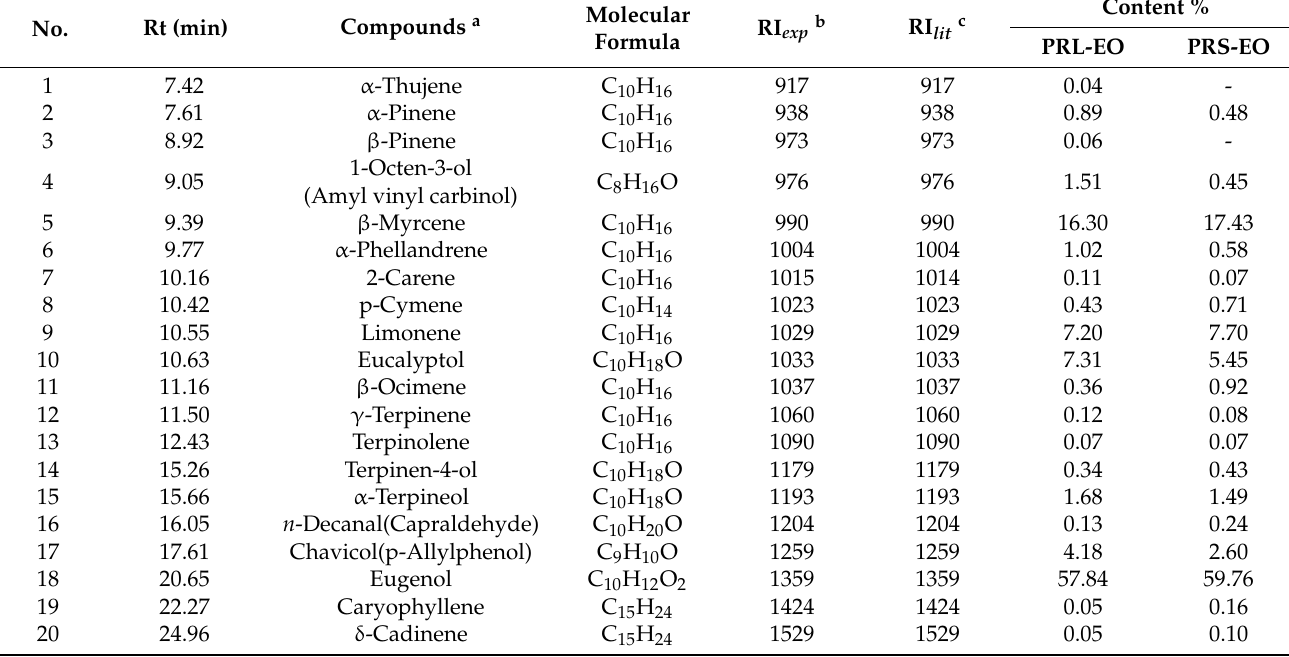
Table 1. Phytochemical profile of the essential oils of P. racemosa leaf (PRL-EO) and stem